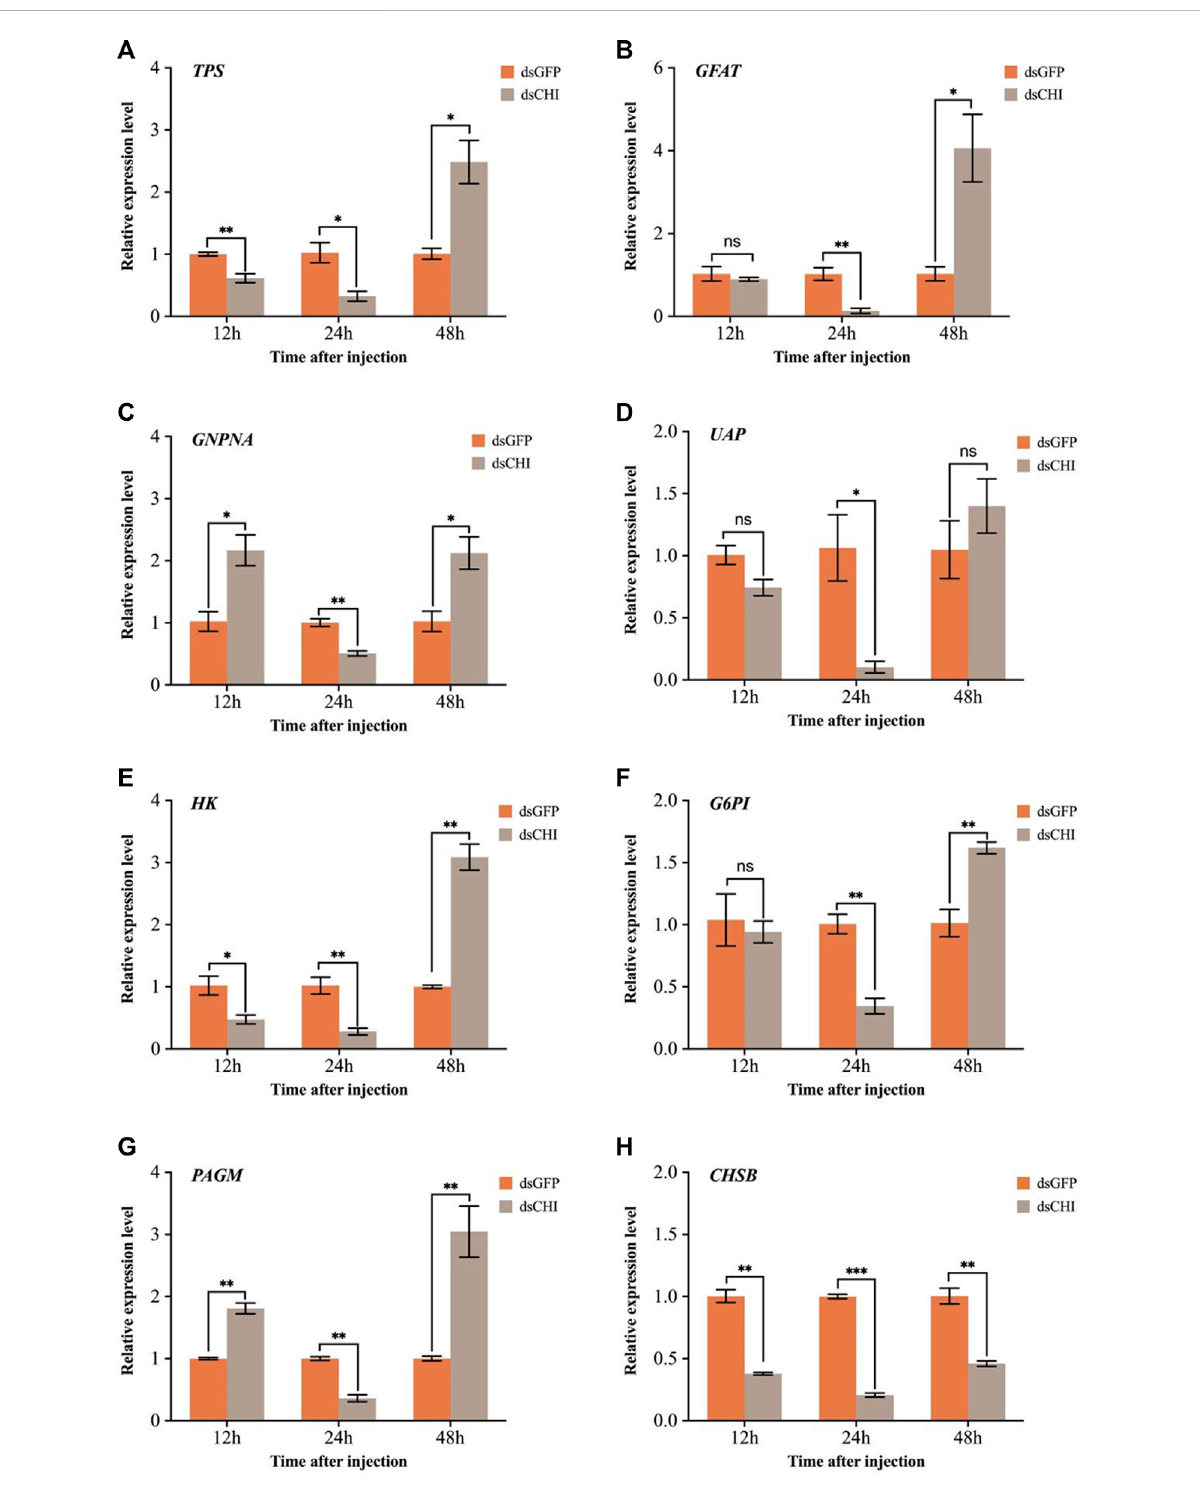
Changes in expression levels of genes related to trehaloseand chitin metabolic pathways after RNAi. (A) TPS, trehalose-6-phosphate synthase; (B) GFAT , glutamine: fructose-6-phosphate amidotransferase; (C) GNPNA , glucosamine-6-phosphate-N-acetyltransferase; (D) UAP , UDP-N- acetylglucosamine pyrophosphorylases; (E) HK , hexokinase; (F) G6PI , glucose-6-phosphate isomerase; (G) PAGM , phosphoacetylglucosamine mutase; (H) CHSB , chitin synthase. Spodoptera frugiperda larvae at the fi rst day of the third instar stage were divided into three groups and injectedwithdsGFPanddsCHI,respectively.Insectswerecollectedandusedtodeterminetherelativeexpressionlevelsofgenesrelatedtotrehalose andchitinmetabolicpathwaysat12,24and48 hafterdsRNAinjection.Threereplicateswereperformedpergroup.(Mean±SE;t-test;*** p < 0.001, ** p < 0.01, * p < 0.05, ns p >